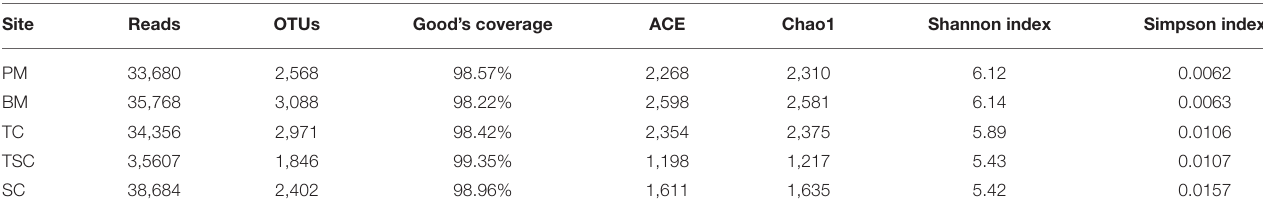
classes of α -, δ -, γ -Proteobacteria, Flavobacteriia, Acidobacteria, Actinobacteria, etc. At the bacterial genus level, these biomarkers belonged to 60 genera, and most enriched in PM with 29 bacterial genera, followed by in BM (12), TSC (10), TC (5), and SC (4) ( Figure 5 ). For example, the result found that 10 genera ( Desulfococcus , Desulfosarcina , the Sva0081 sediment group, no-rank Desulfobulbaceae , unclassified Desulfobulbaceae